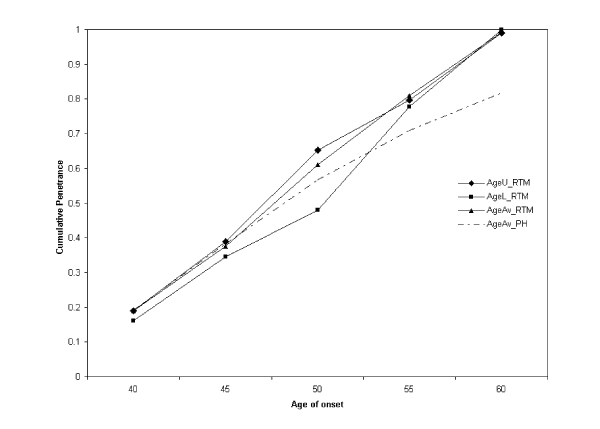
Estimation of the cumulative penetrance among carriers for recessive mode of inheritance models